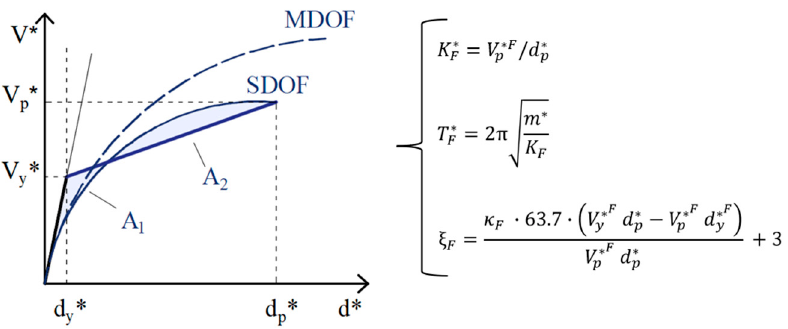
Figure 5. Determination of the equivalent bilinear curve of the main frame according to the Commentary of IBC.